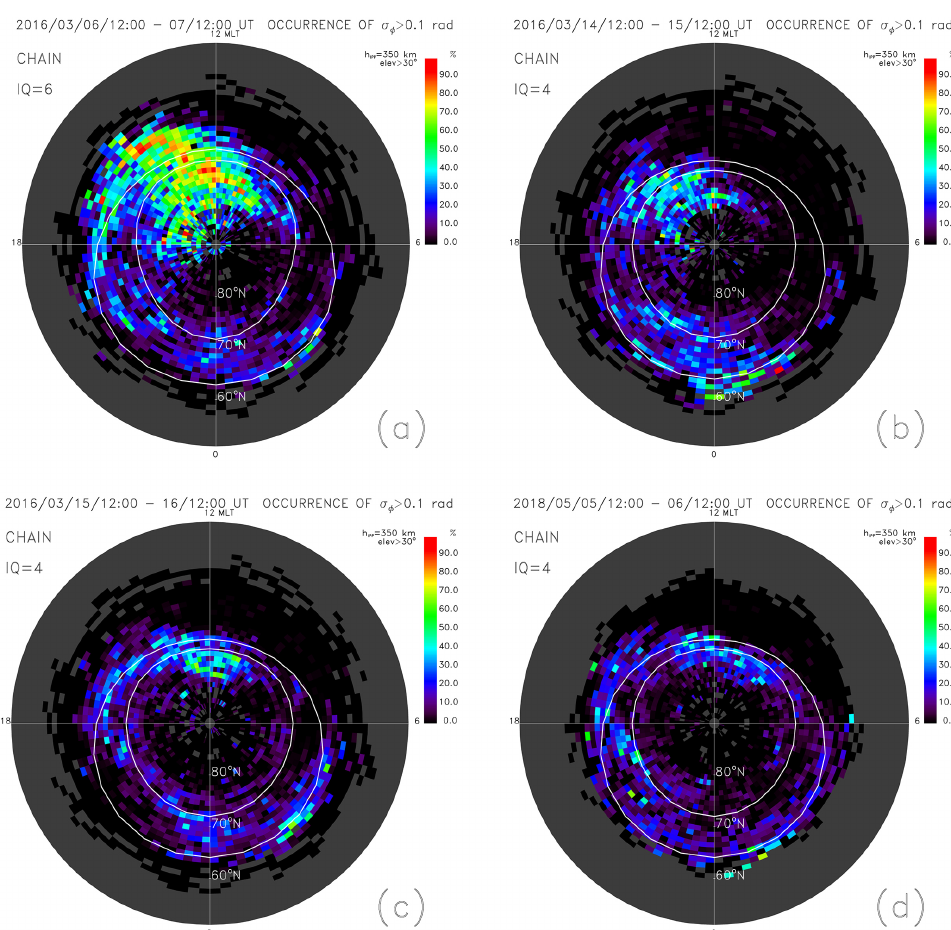
Figure 16. The percentage occurrence of the GPS phase variation σ (cid:56) > 0 . 1rad mapped in coordinates of AACGM latitude and MLT during geomagnetic storms on (a) 6 March, (b) 14 March, (c) 15 March 2016, and (d) 5 May 2018. Boundaries of the statistical auroral oval are